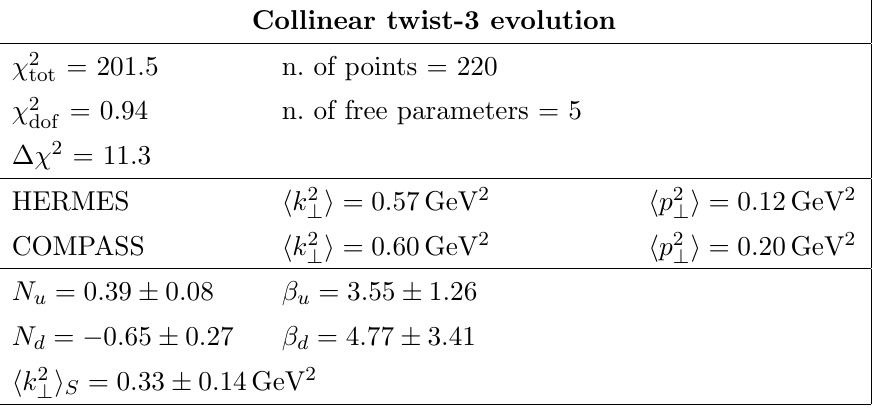
w.r.t. that of the reference (cid:12)t tot